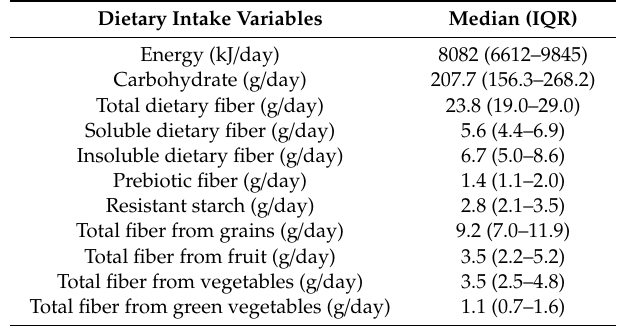
Table 2. Study population ( n = 639) maternal dietary intakes during late